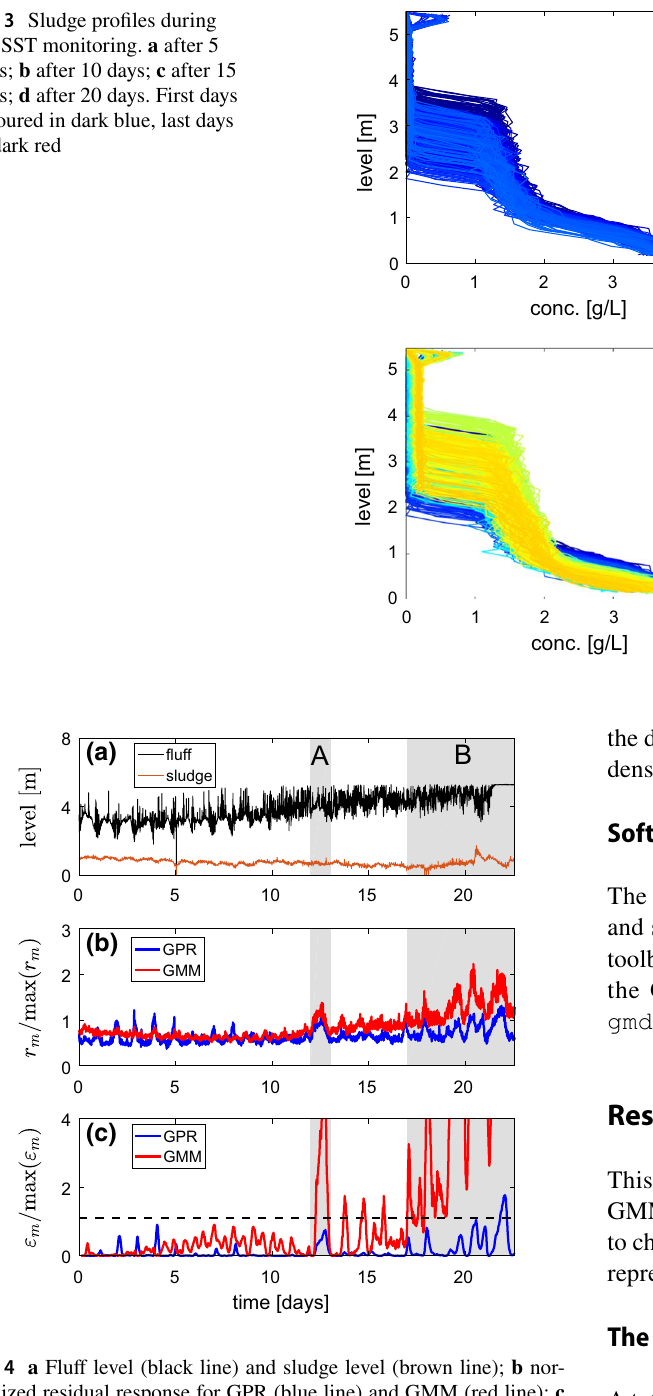
Fig. 4 a Fluff level (black line) and sludge level (brown line); b nor- malized residual response for GPR (blue line) and GMM (red line); c normalized decision rule response for GPR (blue line) and GMM (red 1.1 line), threshold for 𝛼 𝜀 = (black dashed line). Periods A and B are shown as grey